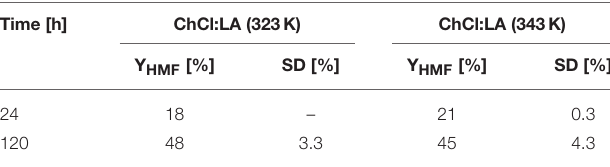
TABLE 1 | 5-Hydroxymethylfurfural (HMF) yields in choline chloride:levulinic acid (ChCl:LA) in a molar ratio of 1:2; reaction temperature: 323 or 343K; fructose starting concentration: 2.5 wt.%; pressure: 1